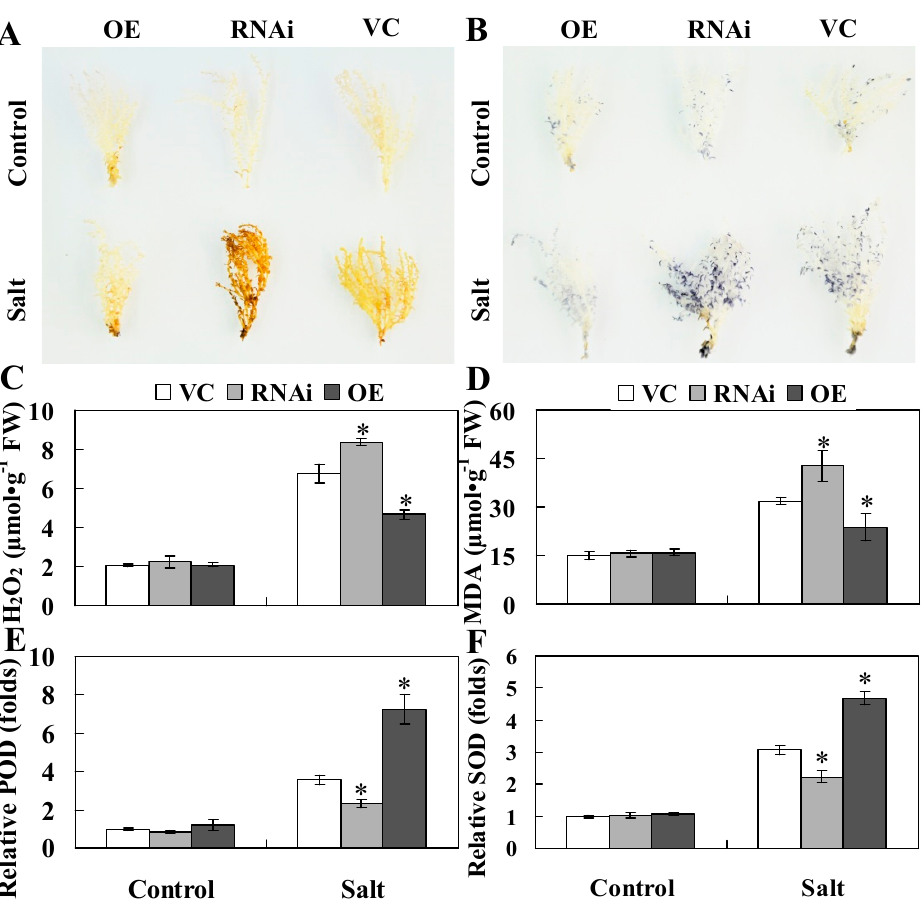
Figure 5. ThHSFA1 decreases ROS levels in T. hispida plants under salt stress. ( A , B ) DAB and NBT staining were used to measure H 2 O 2 and O 2 •− levels. ( C – F ) H 2 O 2 and O 2 •− content and relative POD and SOD activity levels in T. hispida plants. The transiently transformed T . hispida plants were grown on half-strength Murashige–Skoog (1/2 MS) medium supplemented with 0 (control) or 150 mM NaCl (salt) for 24 h, and leaves were collected for histochemical staining and physiological analyses. VC: empty pROKII-transformed T. hispida plants; RNAi: T. hispida plants with transient RNAi-mediated silencing of ThHSFA1 ; OE: T. hispida plants with transient overexpression of ThHSFA1 . The error bars represent ± SD from multiple biological replicates, and the asterisks indicate significant differences between the VC and RNAi or OE plants (*, p < 0.05).